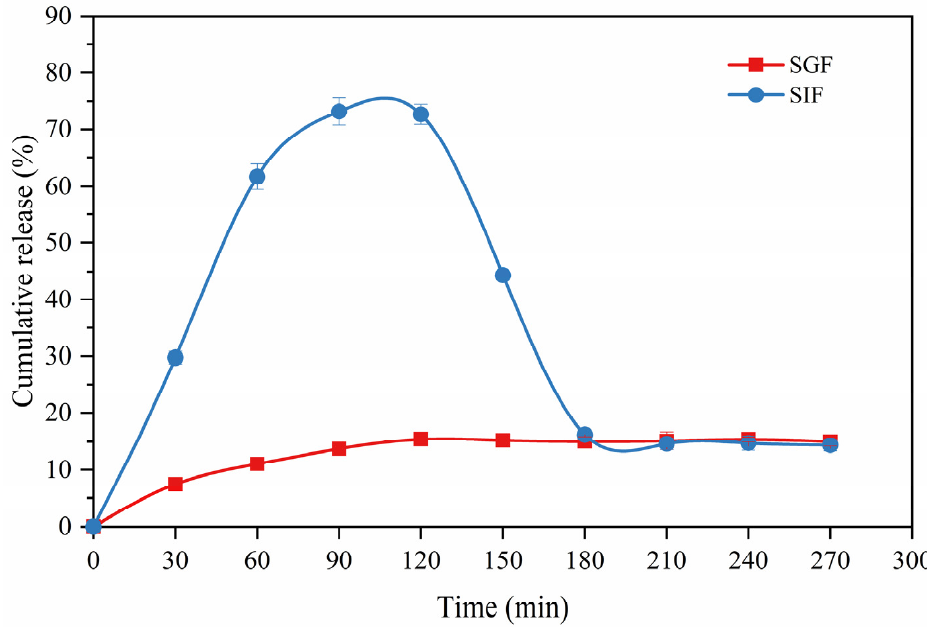
Figure 6. Cumulative release of GLOM in simulated gastric juice and simulated intestinal juice. Table 4. Kinetic release parameters of GLO microcapsules in SGF and SIF.